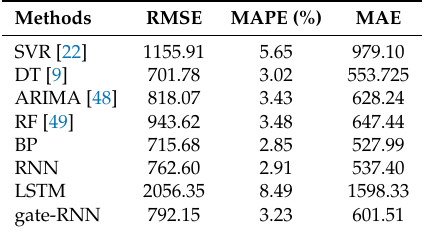
Table 6. Results of eight methods on the 40-min time scale in three months’ test